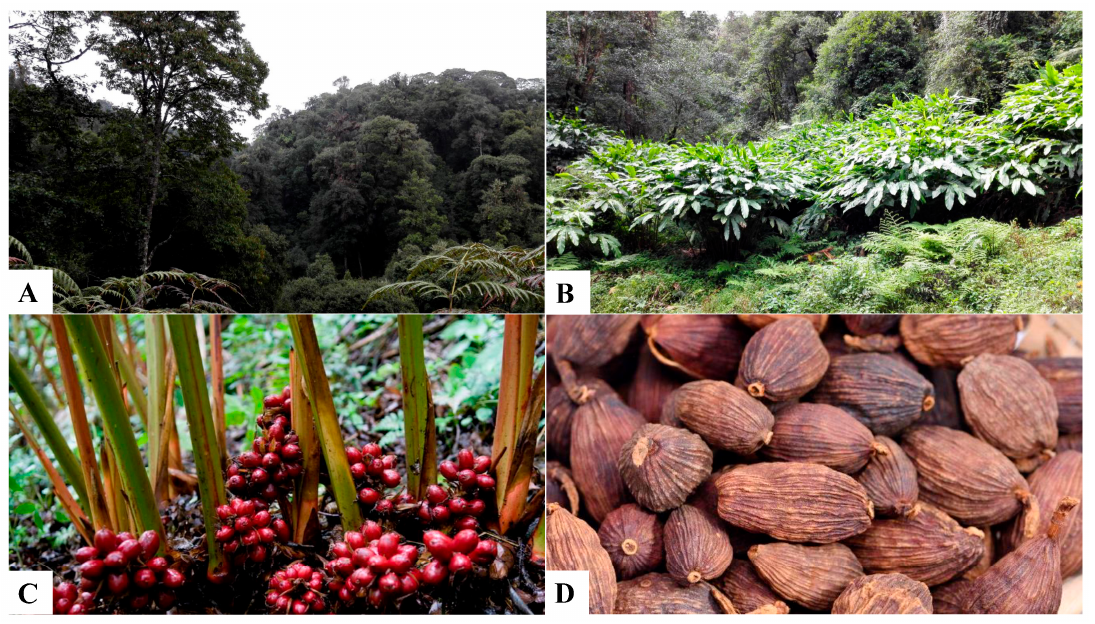
Figure 1. The habitat and morphology of Amomum tsao-ko in the Lancang population, Yunnan Province, China (22°54 ′ 36 ″ N, 99°49 ′ 12 ″ E, 1924 m above sea level). A. tsao-ko plants growing in a typical shady, wet, humus-rich habitat ( A , B ), fresh fruit ( C ), and dried fruit ( D ).